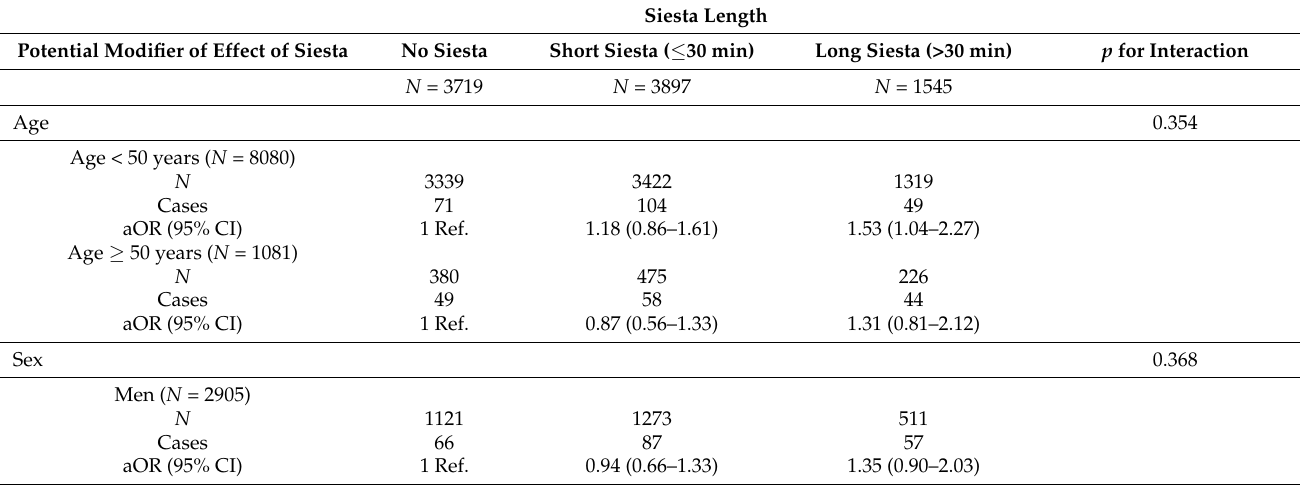
Table 4. Analysis of effect modification: Adjusted odd ratios (aOR) * and 95% confidence intervals (CI) for the develop-